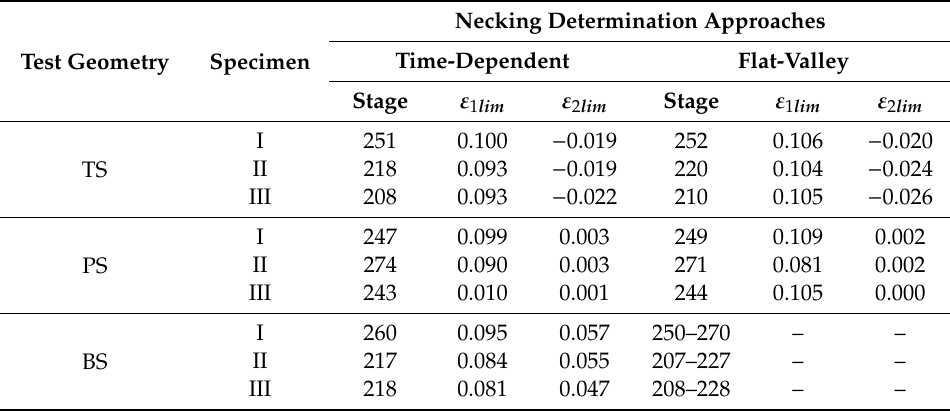
Table 2. Summary of the experimental work plan for PC